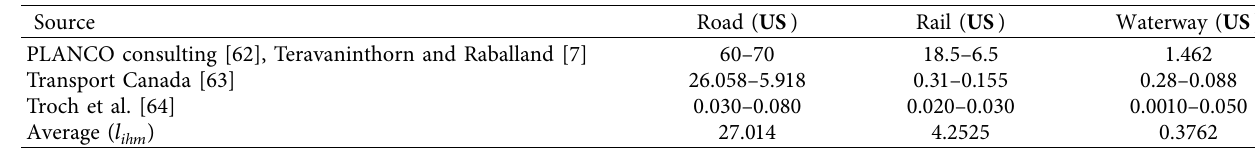
Figure 4: Node type and node centrality. Table 4: Transportation cost per mode.